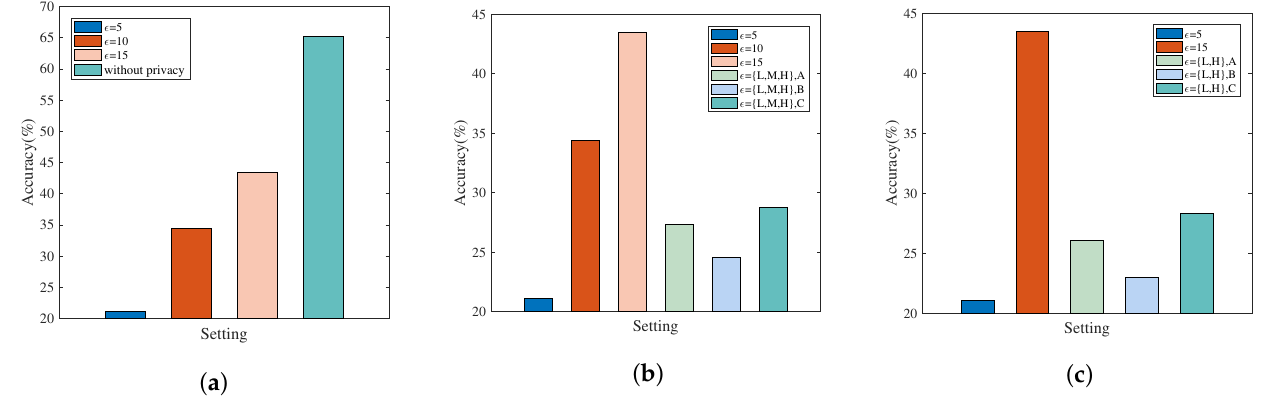
Figure 5. Simulation results on MNIST data. Clients’ training data are non-independent and identically distributed. (a) The non-personalized scenario. ( b ) The personalized scenario un- der the first privacy setting. ( c ) The personalized scenario under the second privacy